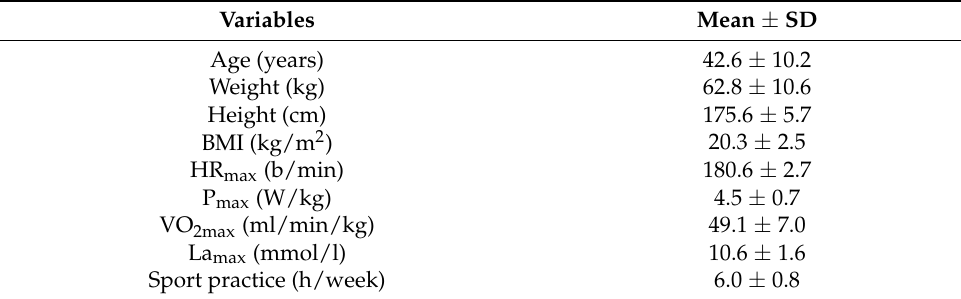
Table 1. Baseline characteristics of the participants ( n = 5).